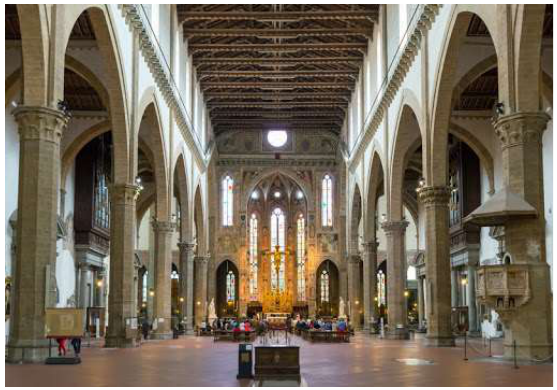
Figure 1 . The basilica of Santa Croce,